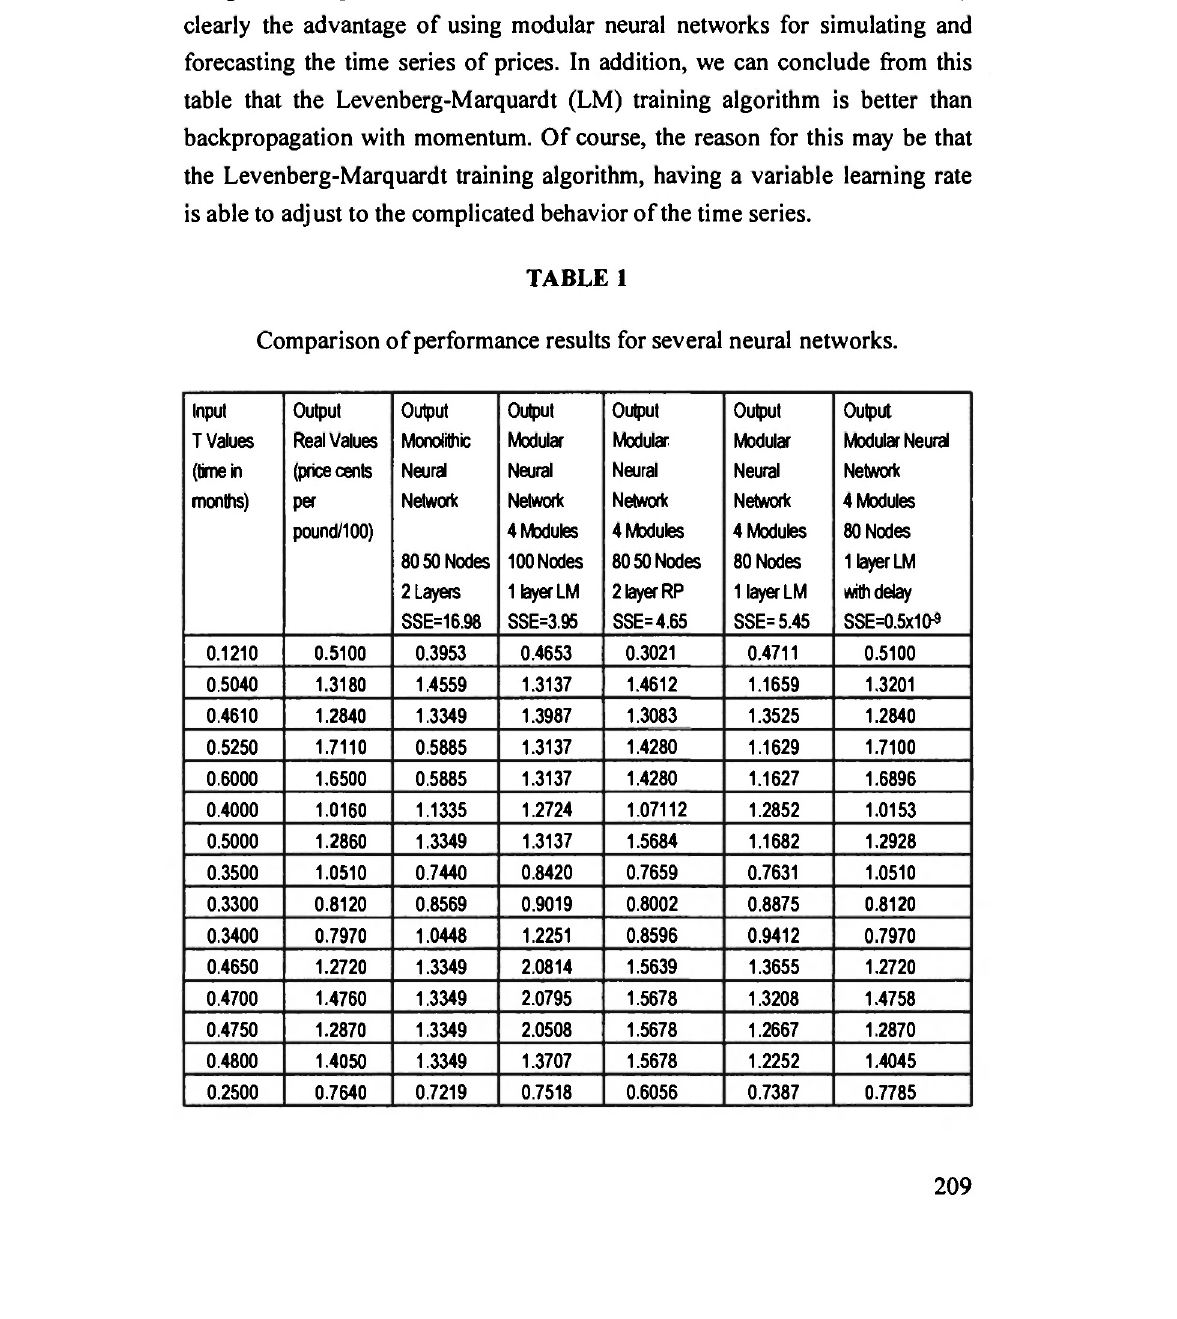
Comparison of performance results for several neural